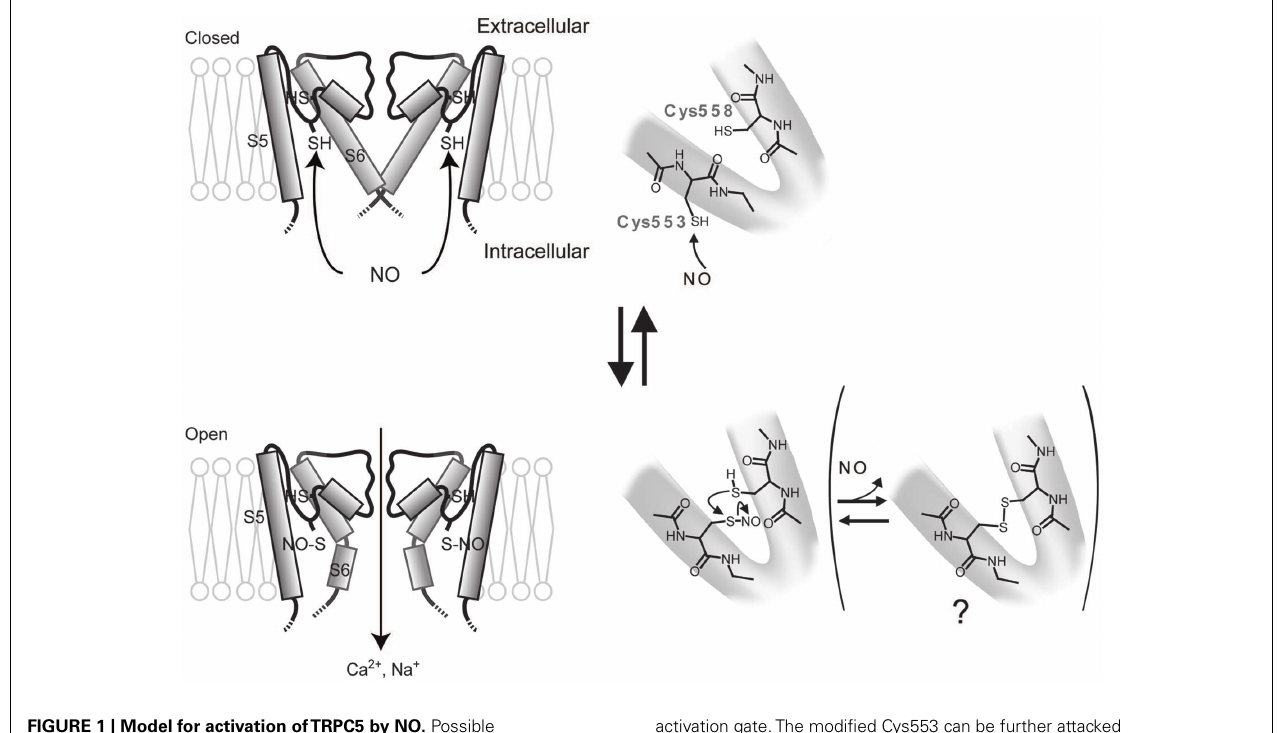
FIGURE 1 | Model for activation ofTRPC5 by NO. Possible protein conformation changes and chemical reactions during activation ofTRPC5 by NO. NO modify the free sulfhydryl group of Cys553 accessible from the cytoplasmic side to open the